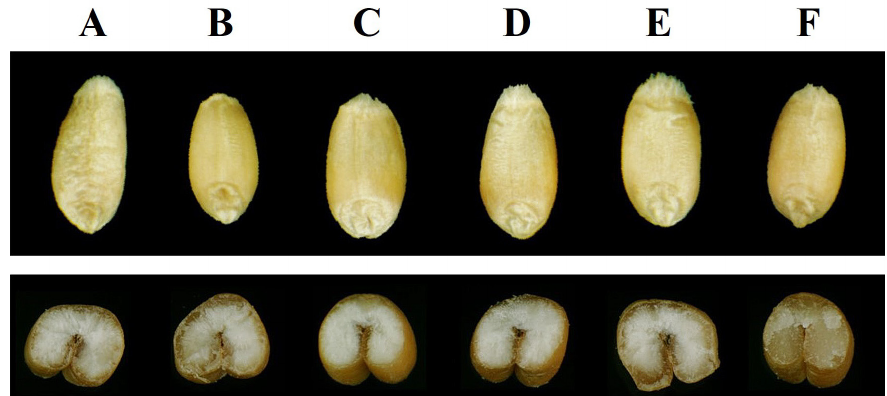
Fig. 1: Images of kernels of the studied spring wheat cultivars: Ostka Smolnicka (A), Arabella (B), Izera (C), Tybalt (D), KWS Torridon (E), Łagwa